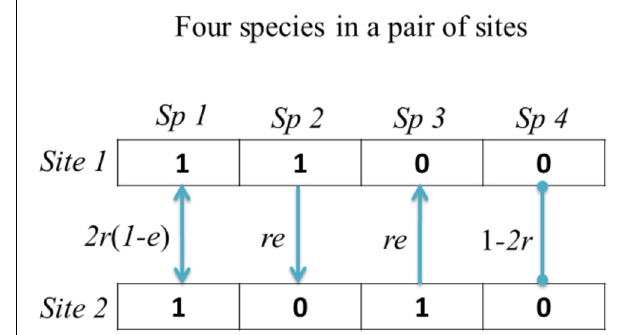
FIGURE 1 | A schematic map showing the modeling framework of the colonization and extinction events in a pair of sites. Solid lines with arrow endpoints denote respective dispersal directions, while lines with circle endpoints denote no event. These events in our study follow the parsimonious